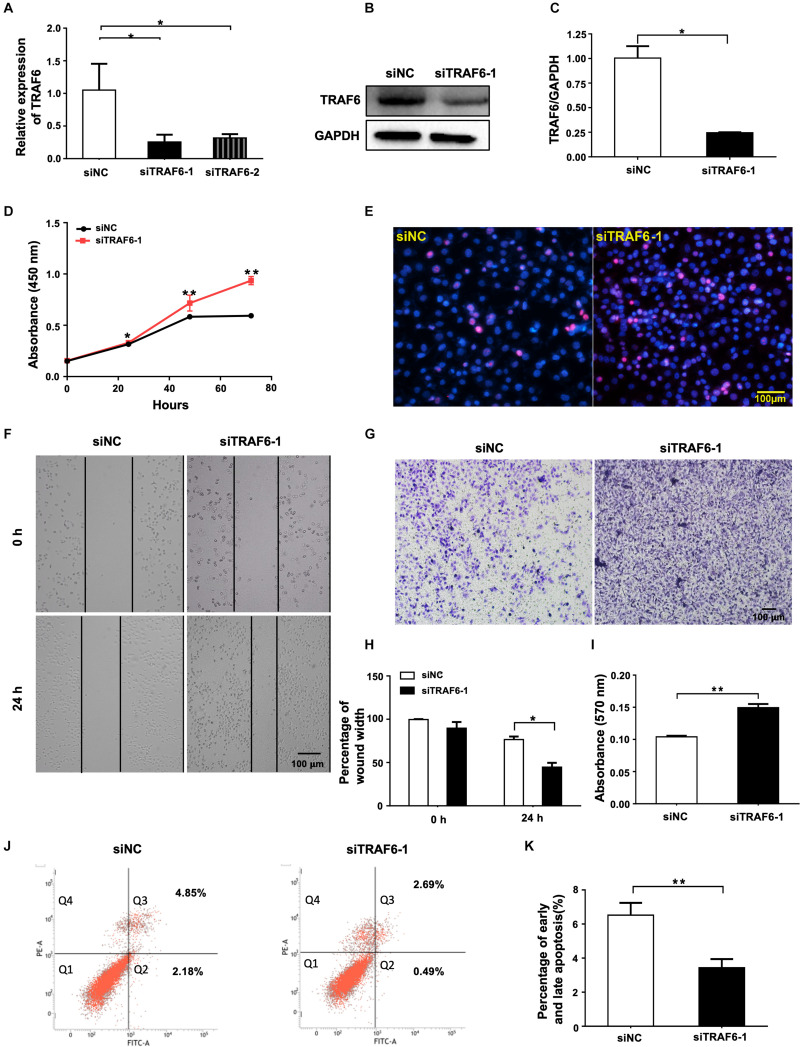
TRAF6 silencing promotes cell proliferation and migration but inhibits apoptosis of NSCLC cells. (A) mRNA expression of TRAF6 measured by qRT-PCR. (B) The protein level of TRAF6. (C) Quantitation of the WB data as in (B). (D) Cell proliferation examined by CCK-8 assay. (E) Cell proliferation measured by Ki-67 staining. (F) Migration ability measured by wound-healing assay. (G) Migration ability detected by transwell assay. (H) Quantification of the wound-healing assay result as in (F). (I) Quantification of the transwell assay result as in (G). (J) Early (Q2) and late apoptosis (Q3) determined by flow cytometry analysis. (K) Quantification of the FACS data as in (J). All experiments were performed in A549 cells transfected with siRNA for 24 h except in (B,J) for 48 h.